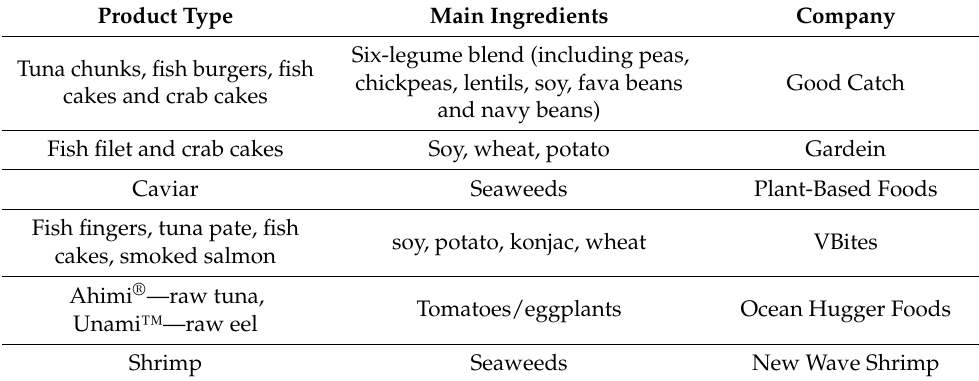
Table 1. Plant-based fish and seafood alternatives on the market, or under